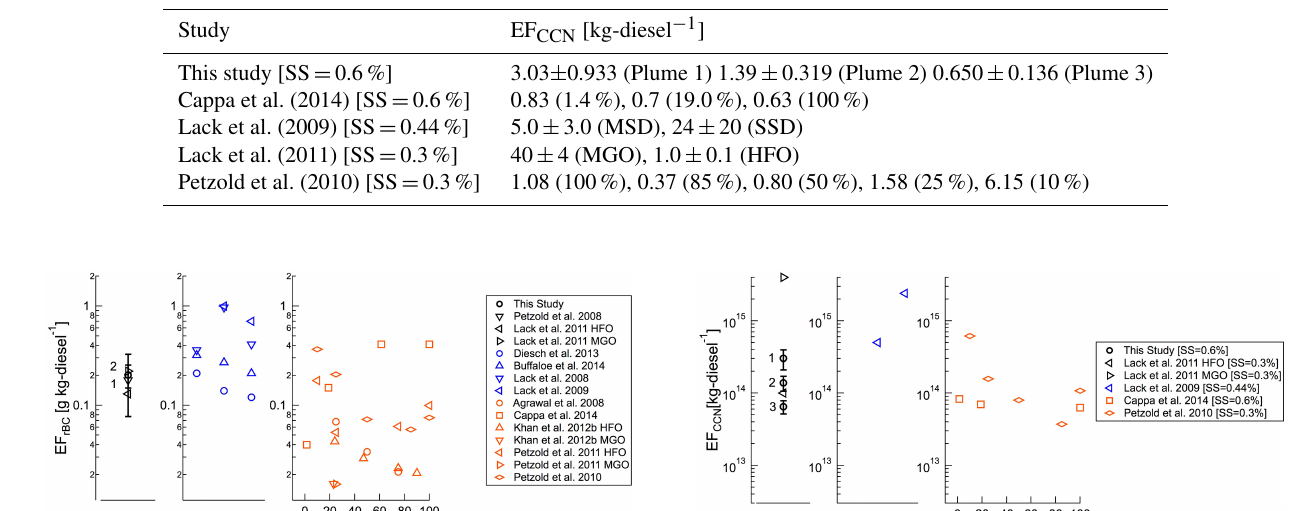
Table 7. Emission factors for cloud condensation nuclei × 10 14 ; numbers in brackets indicate engine load (%), fuel type (HFO: heavy fuel oil with high sulfur content, and MGO: marine gas oil with low sulfur content), or vessel class based on gross metric tonnage (HSD: high speed diesel < 5000t, MSD: medium speed diesel 5000–30000t, or SSD: slow speed diesel > 50000t); the uncertainty is computed using the orthogonal distance regression (ODR) method.